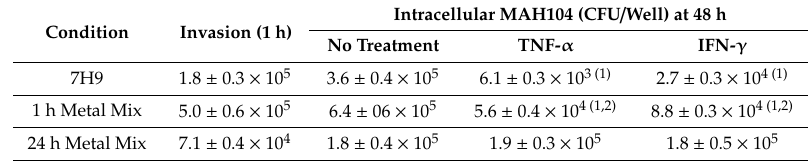
Table 3. MAH 104 survival in TNF- α and IFN- γ stimulated THP-1 cells. Condition